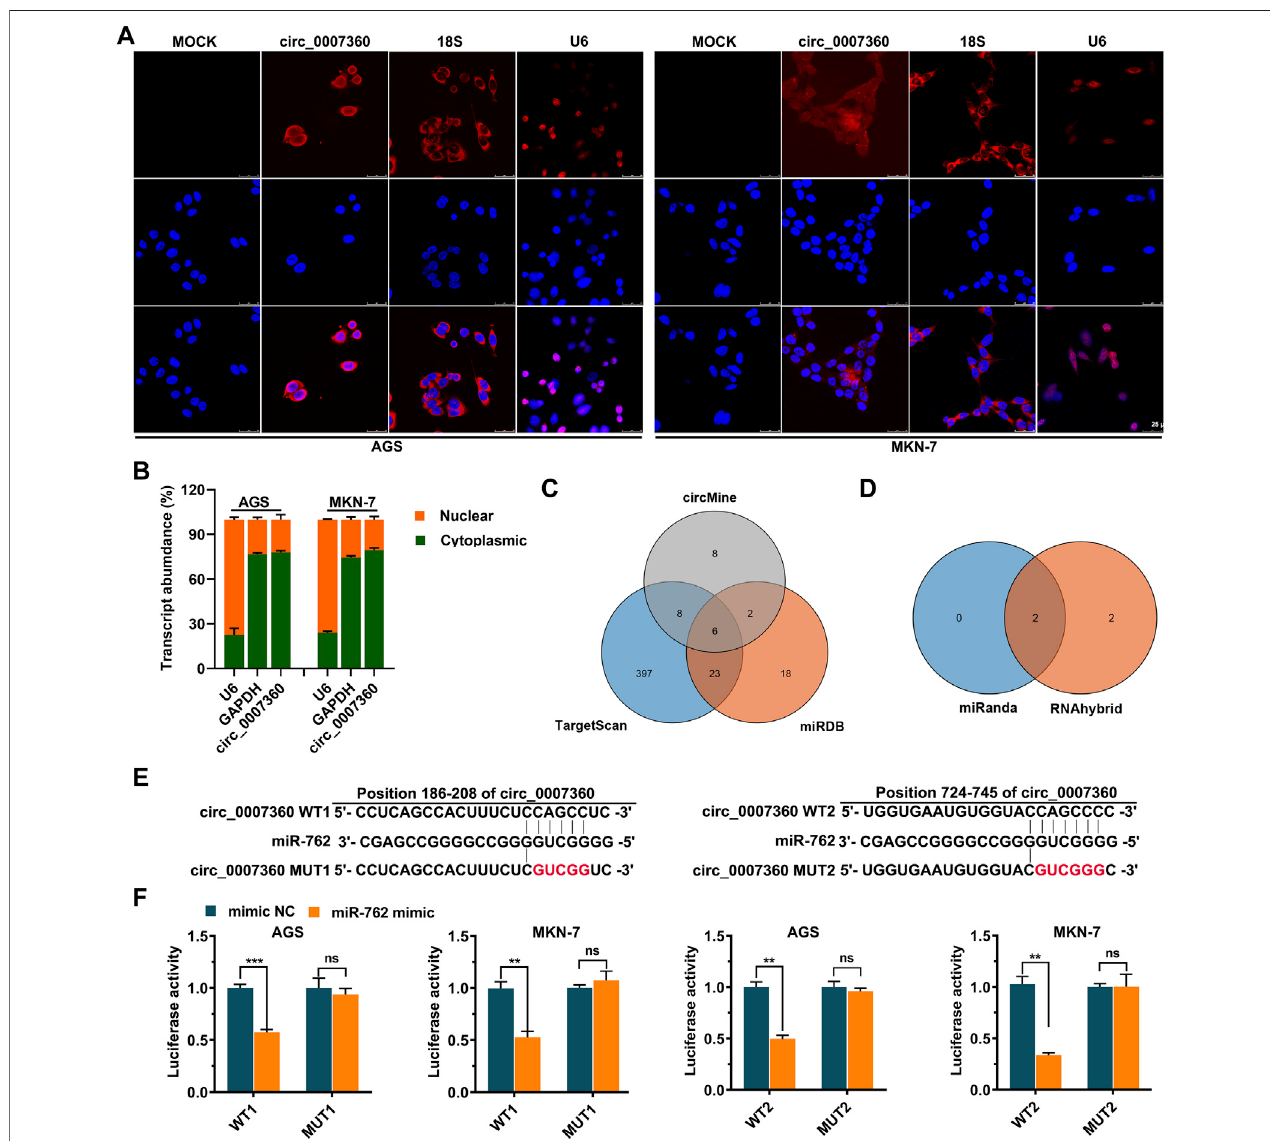
FIGURE 2 | Circ0007360 is a cytoplasmic circular RNA that may sponge miR-762 . (A) Representative images from RNA fl uorescent in situ hybridization (FISH) for detecting circ0007360 , 18S ,or U6 RNA.DAPIwasappliedtostainthenucleus. (B) Subcellularfractionationassaytomeasurethelevelsof U6 , GAPDH ,or circ0007360 in the nucleus or cytoplasm. (C) Schematic plot showing the interacting site between wild type (WT) or mutant (MUT) circ0007360 and miR-762 . (D) The relative luciferase activity of WT or MUT circ0007360 constructs in the presence or absence of miR-762 mimic.